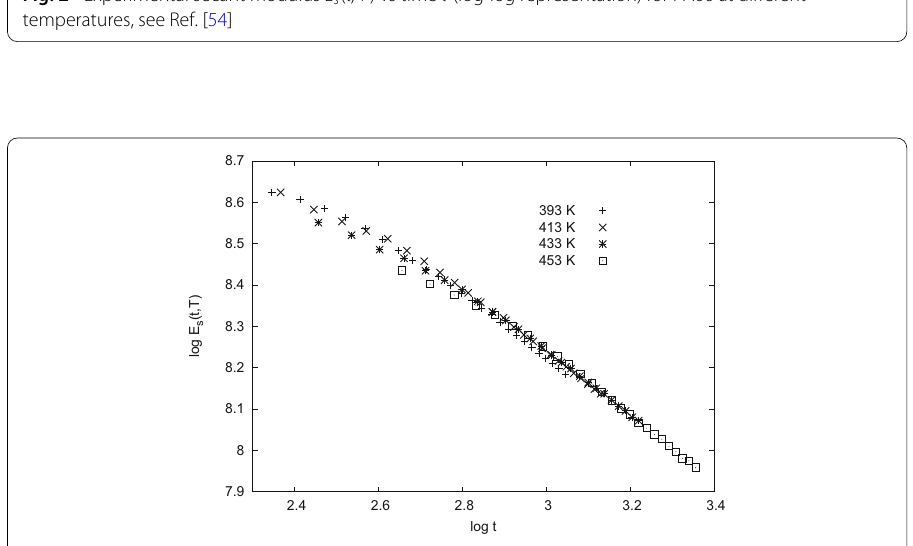
Fig. 3 Master curve obtained at 393K by translation of curves in Fig. 2 along the time axis, see Ref.